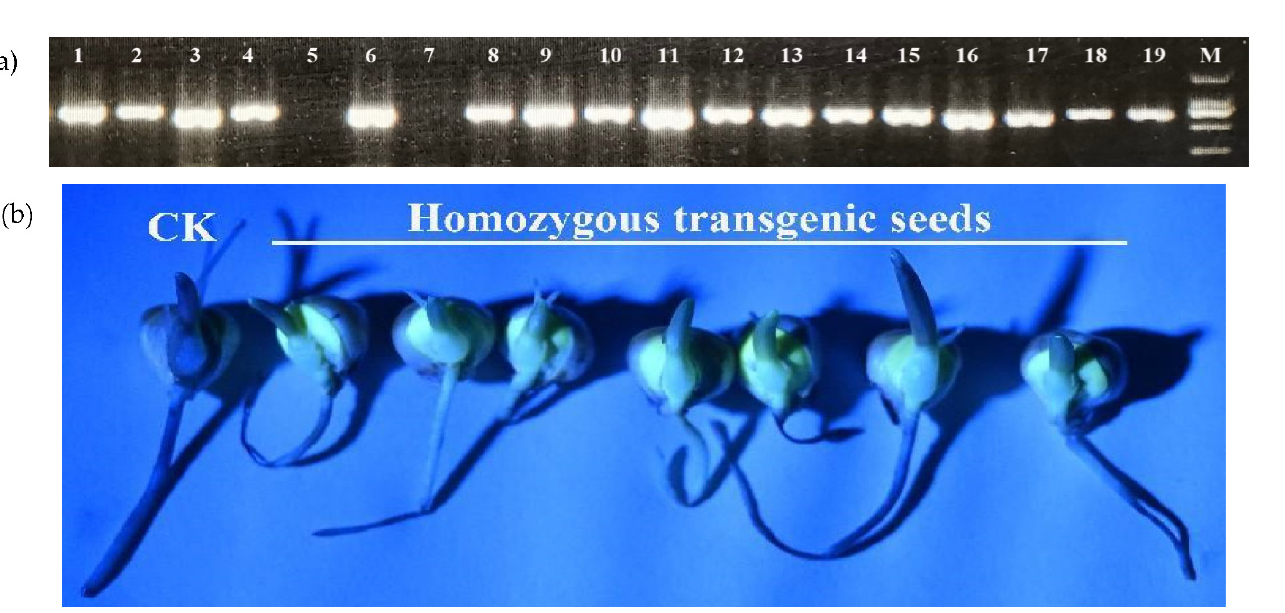
Figure 3. Subcellular localization of YFP-aequorin in maize protoplast. ( a ) YFP-aequorin, ( b ) chlo- rophyll, ( c ) bright field, ( d ) merged image.